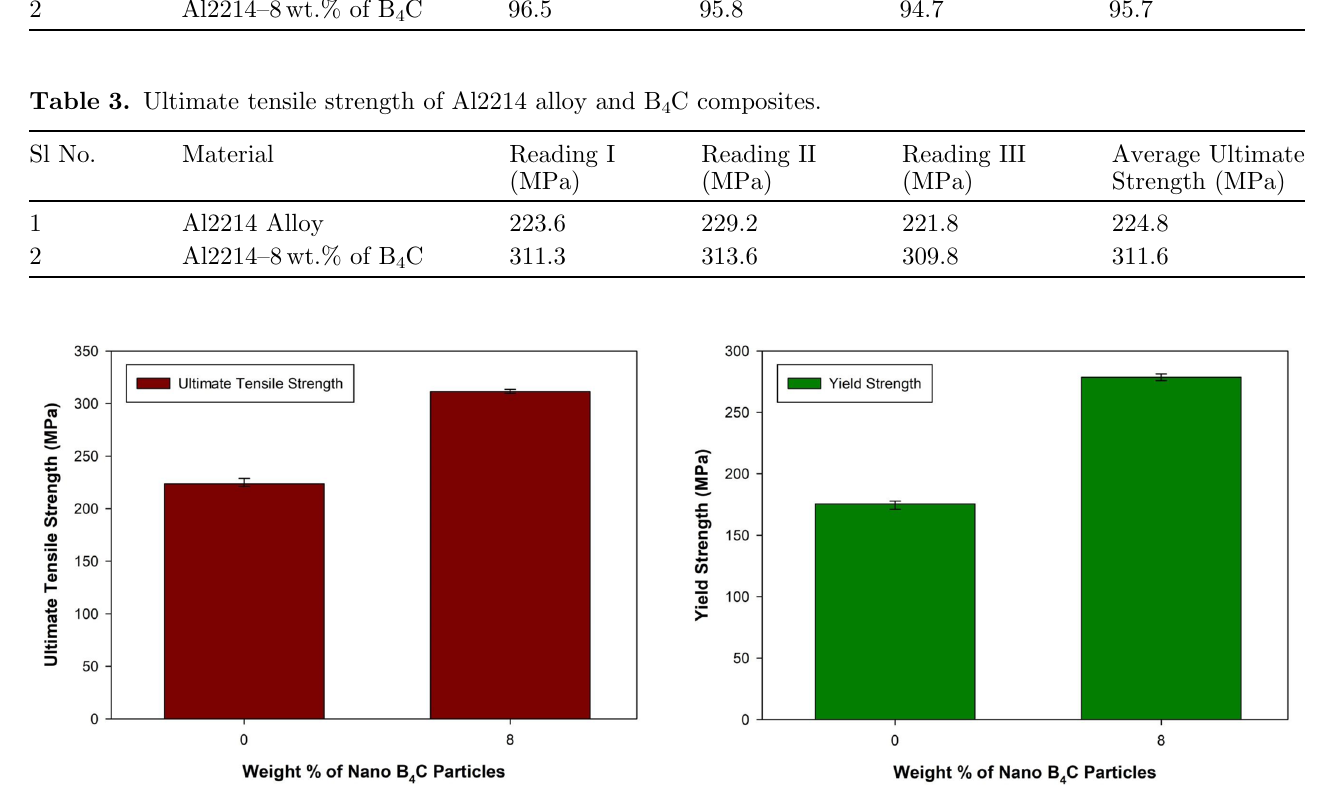
Fig. 10. Yield strength of Al2214 alloy and its composites. Fig. 9. Ultimate strength of Al2214alloy and B 4 C reinforced